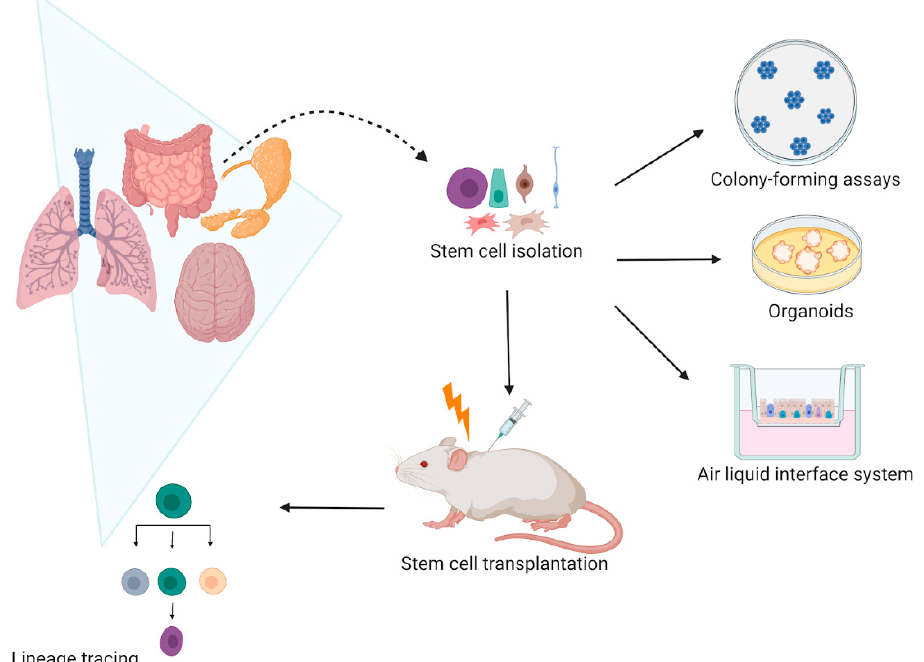
Figure 1. Current models use to assess stem cell radiation response in vivo and in vitro. In vitro the self-renewal potential of stem cells is evaluated by assessing their colony-forming efficiency in clonogenic assays. The stem cell self-renewal potential is also studied in three-dimensional (3D) organoids and air–liquid interface (ALI) systems that not only allow stem cell radiation response studies, but also their differentiation capacity upon irradiation. In vivo, the stem cell lineage tracing remains the most used model that enables to specifically mark stem cells and follow their cell fate. Therefore, it is possible to characterize how irradiation affects the stem cell self-renewal and differentiation capacity. Created with BioRender.com.